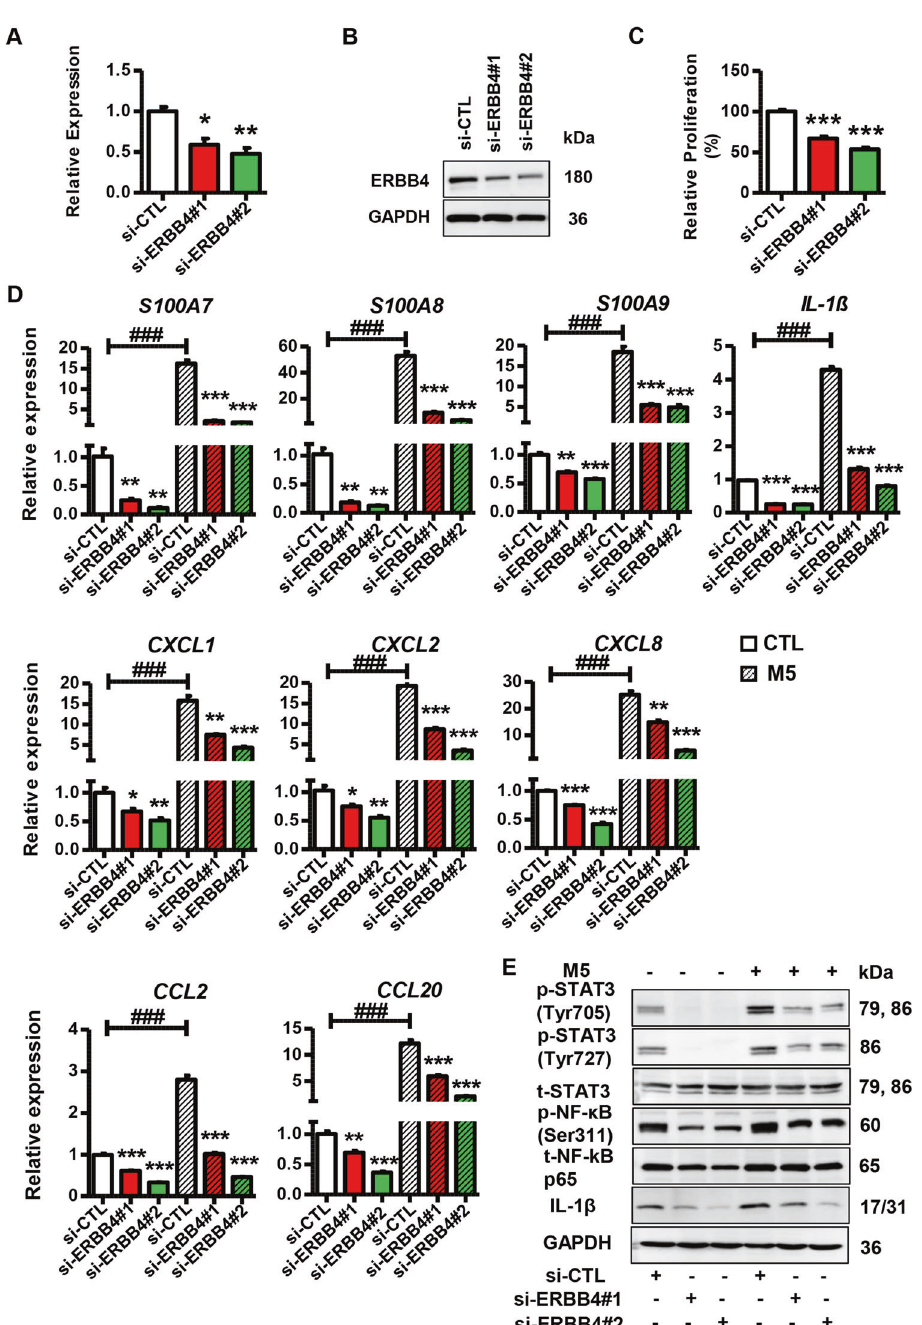
Fig. 6 Function of ERBB4 knock down in keratinocytes. A Expression levels of ERBB4 in HaCaT cells transfected with ERBB4 siRNAs or si-CTL. si-ERBB4#1 and si-ERBB4#2 means two siRNAs speci fi cally targeting ERBB4, while si-CTL means control for interference RNAs. Cells were collected 2 days after transfection and mRNA levels were analyzed using qRT-PCR. GAPDH was used as the internal control. Each bar represents mean ± SEM ( n = 3). ** P < 0.01, * P < 0.05, compared with the indicated controls. B Representative blots showing protein levels of ERBB4 in HaCaT cells transfected with ERBB4 siRNAs or si-CTL. Protein levels were detected by western blotting. GAPDH was used as a protein loading control. C Relative proliferation rate of HaCaT cells transfected with ERBB4 siRNAs or si-CTL. Cell proliferation was analyzed using MTT assay. Each bar represents mean ± SEM ( n = 3). *** P < 0.001, compared with the indicated controls. D The mRNA levels of psoriasis-related genes and in fl ammatory genes in HaCaT cells transfected with ERBB4 siRNAs or si-CTL in the presence or absence of M5 treatment. Cells were collected 2 days after transfection and mRNA levels were analyzed using qRT-PCR. GAPDH was used as the internal control. Each bar represents mean ± SEM ( n = 3). *** P < 0.001, ** P < 0.01, * P < 0.05, ### P < 0.001 compared with the indicated controls. E Representative blots showing the levels of phospho-STAT3 (Tyr705), phospho-STAT3 (Ser727), phospho-NF- κ B p65 (Ser311), and IL-1 β in HaCaT cells transfected with ERBB4 siRNAs or si-CTL in the presence or absence of M5 treatment. Protein levels were detected by western blotting. GAPDH was used as a protein loading